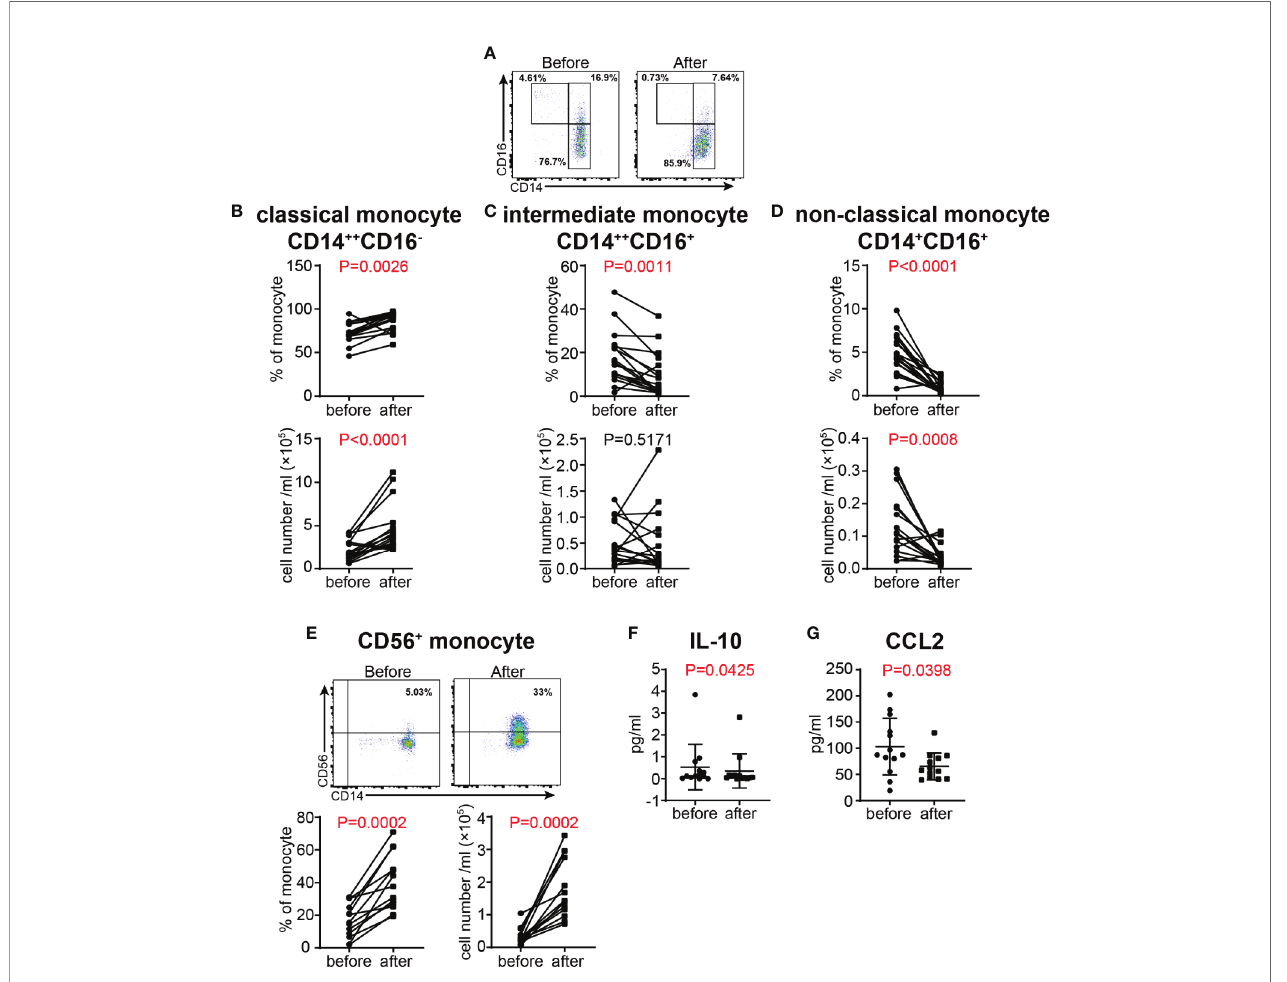
FIGURE 8 | Changes of monocyte subsets in VKH patients before and after GC treatment. (A) Monocyte subsets in a VKH patient before and after GC treatment. The absolute number and proportion of classical monocytes (B) , intermediate monocytes (C) , non-classical monocytes (D) and (E) CD56 + monocytes. Statistical analysis was performed using Wilcoxon test. Plasma levels of IL-10 (F) andCCL2 (pg/ml) (G) in VKH patients before and after GC